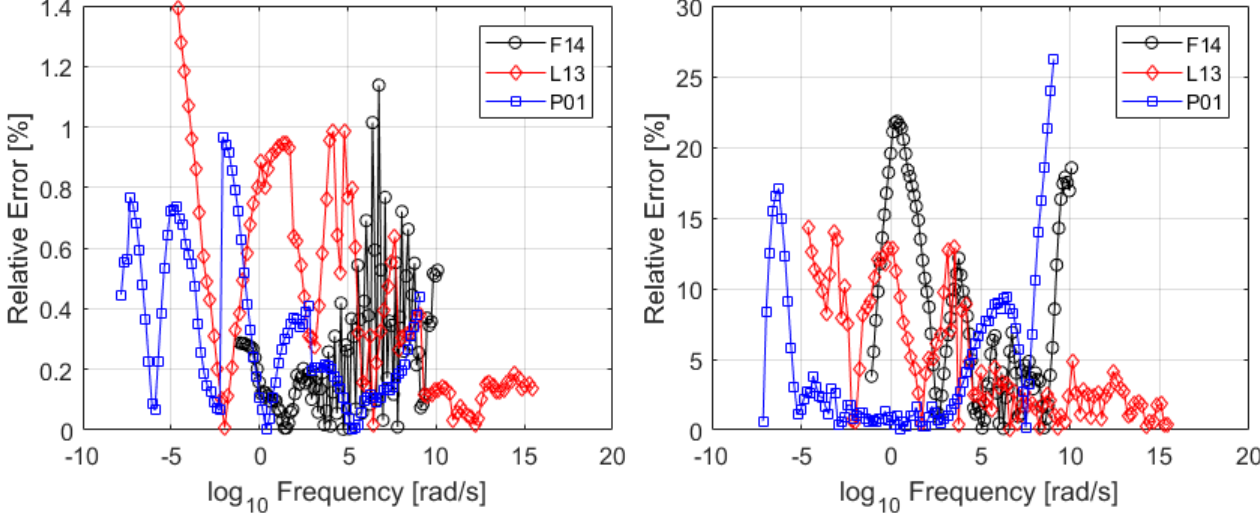
Figure 8. Storage moduli ( left chart ) and loss tangents ( right chart ) relative error for three rubber